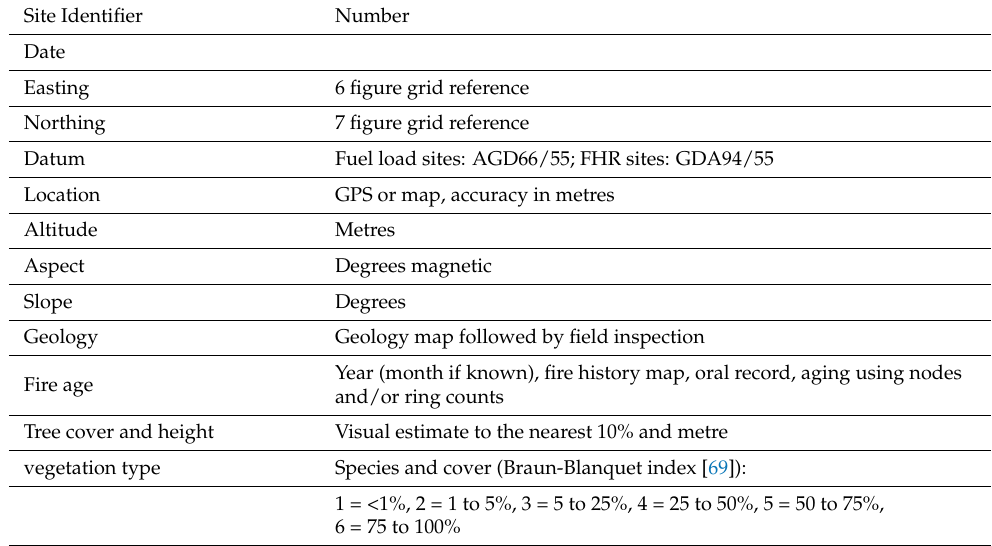
Table A4. Field Data Collected. Site data collected.